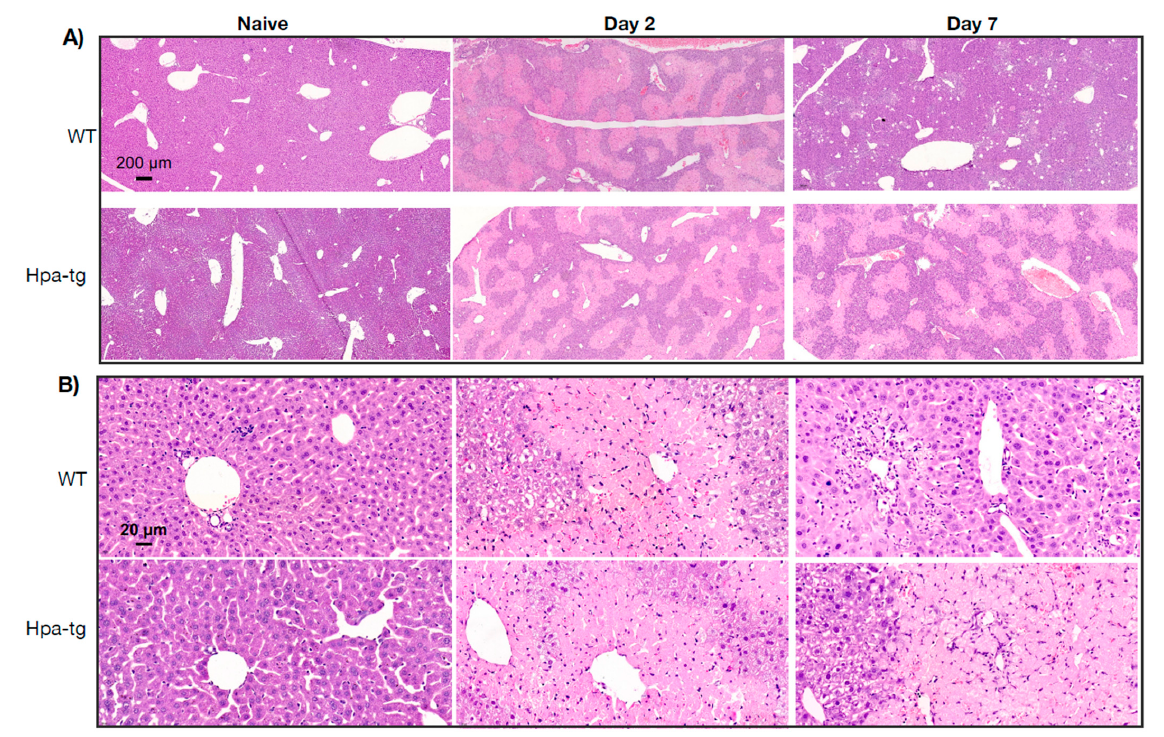
Figure 2. H&E staining of paraffin-embedded liver sections from naïve and CCL4 treated WT and Hpa-tg mice. ( A , B ) Large damaged areas are seen 2 days after treatment, with no substantial difference between the two groups. On day 7, the damaged area was markedly reduced in the WT but not the Hpa-tg liver. Shown are representative images at low (×5, upper panels) and high (×40, lower panels) magnifications.